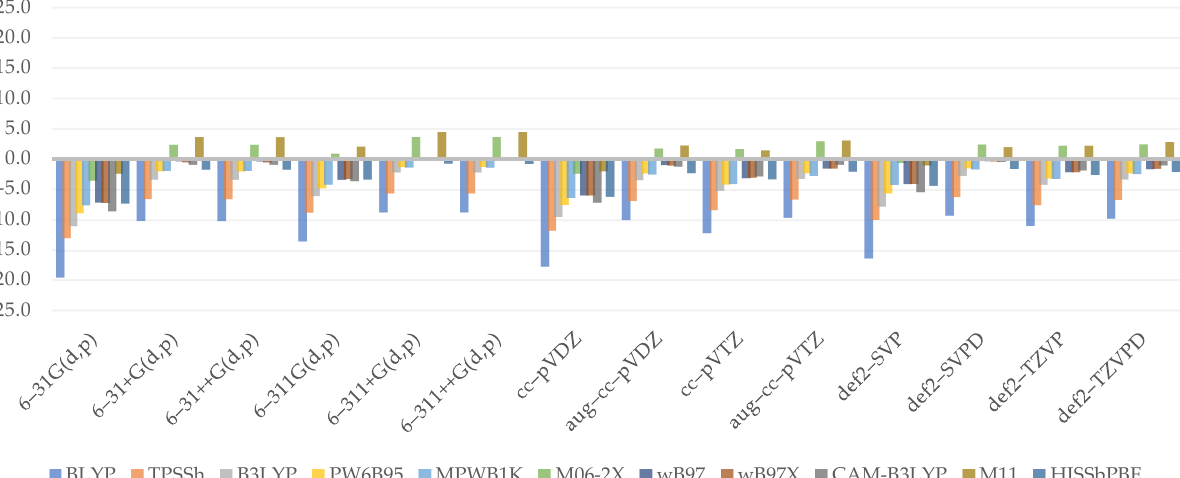
Figure 3. Relative errors to reference value for adiabatic ionization potential (kcal/mol).